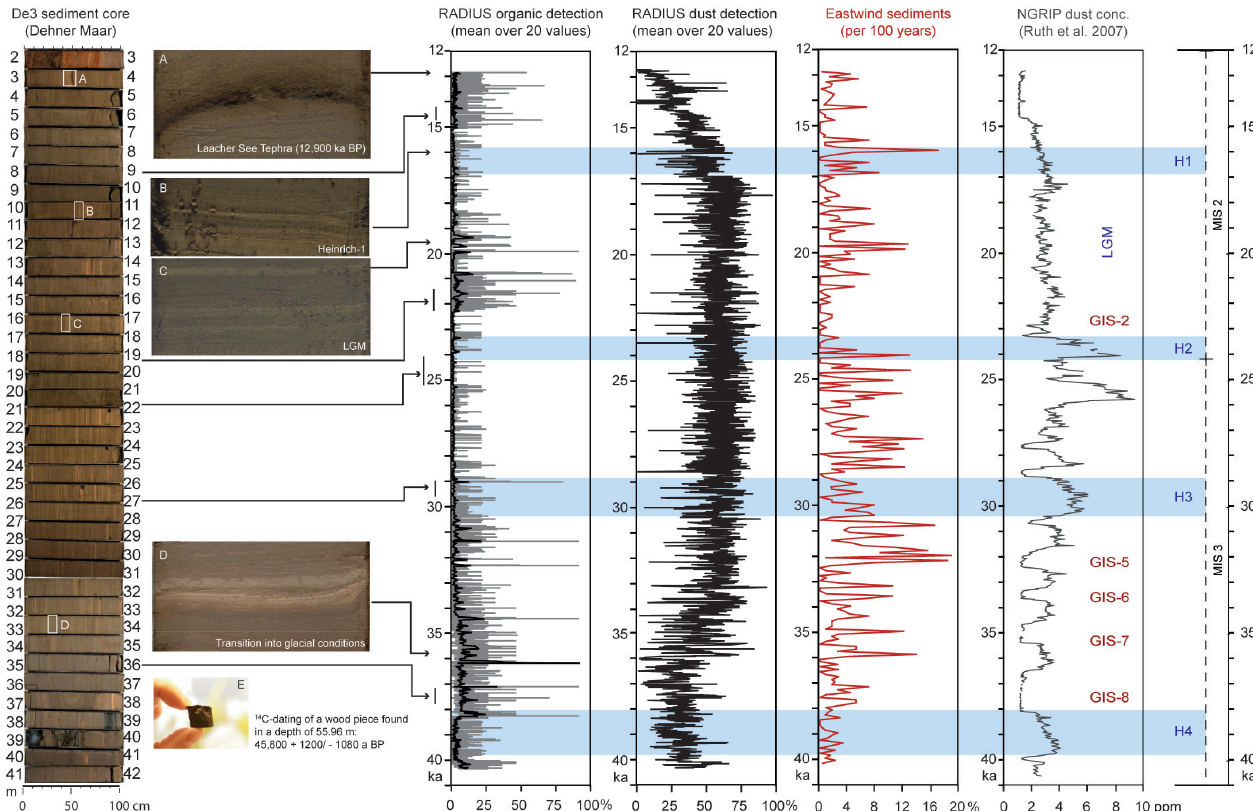
Fig. 5. Core sequence De3 40.3–12.8kaBP (Dehner Maar): left: core images over the whole sequence (2–42m); center-left: detailed sediment images: (A) Laacher See Tephra (LST, 12900yearsBP), (B) Heinrich-1 equivalent layer, (C) example of a LGM layer, (D) transition into MIS-2, (E) 14 C-dating of a piece of wood (spruce) found in a depth of 55.96m (45.8+1.2/ − 1.08kaBP); center-right: Radius detection records for the content of organics, Radius detection of dust (both with an original sampling resolution of 500µm, Seelos et al. (2009)). Frequency of carbonate rich east wind sediments per 100 years (red). The comparison with the micro particles record (gray) from Greenland (Ruth et al., 2007) shows a common process of eolian dynamics linking North Atlantic and the European region. Blue bars: marking of Heinrich events (Hemming,